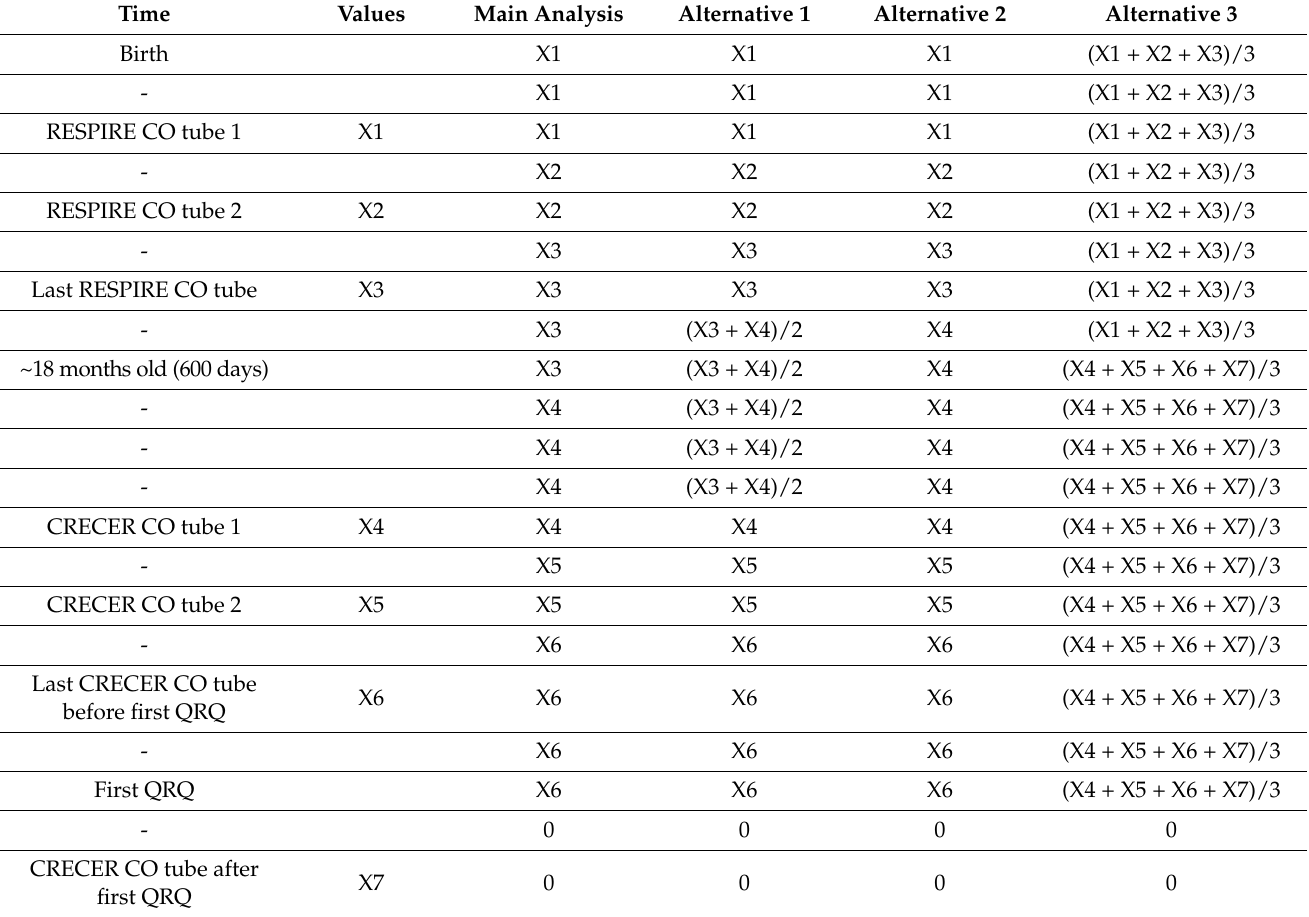
Table A1. Cumulative CO exposure calculation based on RESPIRE and CRECER 48-h personal CO tube